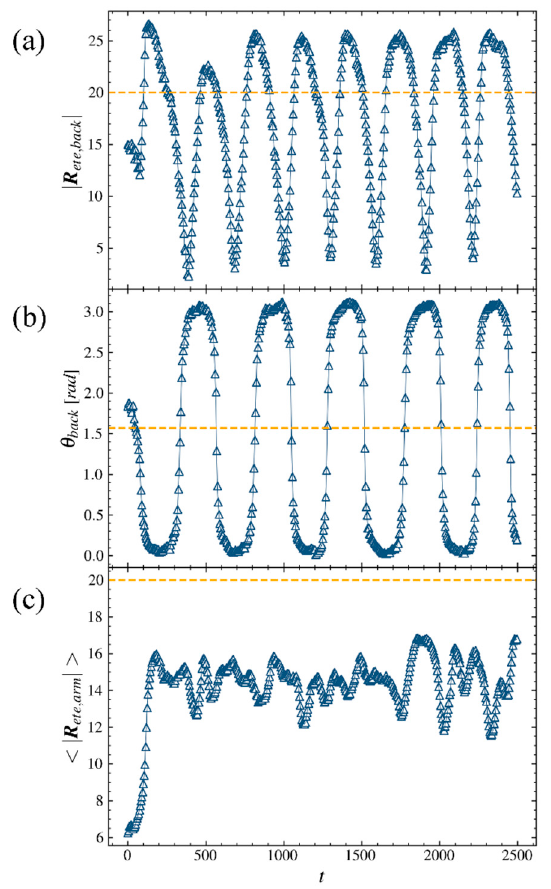
Figure 2. ( a ) The end-to-end distance of the backbone, ( b ) the angle that the backbone’s end-to-end vector makes with respect to the flow direction in xoz plane, here the unit of angle is radian. ( c ) The mean end-to-end distances of arms of the LCB polymer are plotted as a function of time. Here 20 L = . L b = 20, L a = 20 and Wi = b